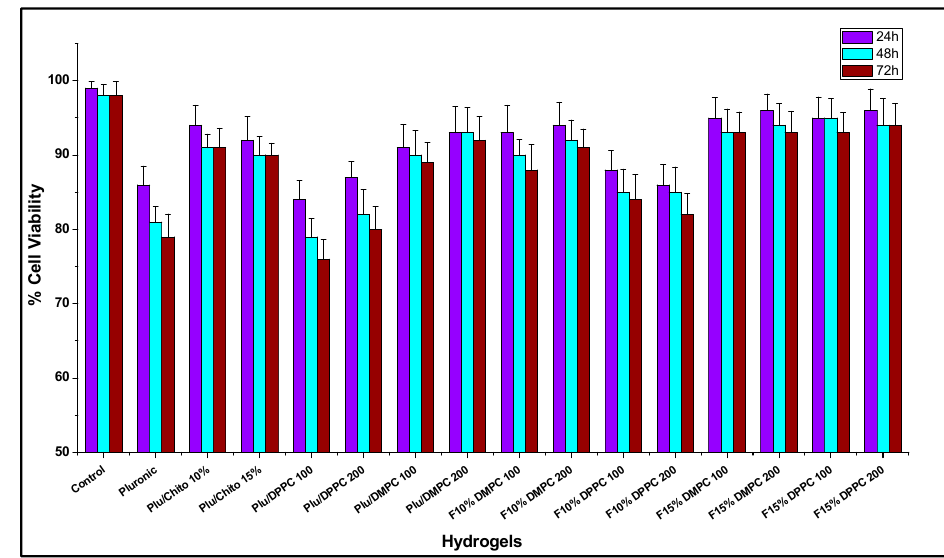
Figure 3. Cell viability of PC12 cells encapsulated in different hydrogels for 24 to 72 h.